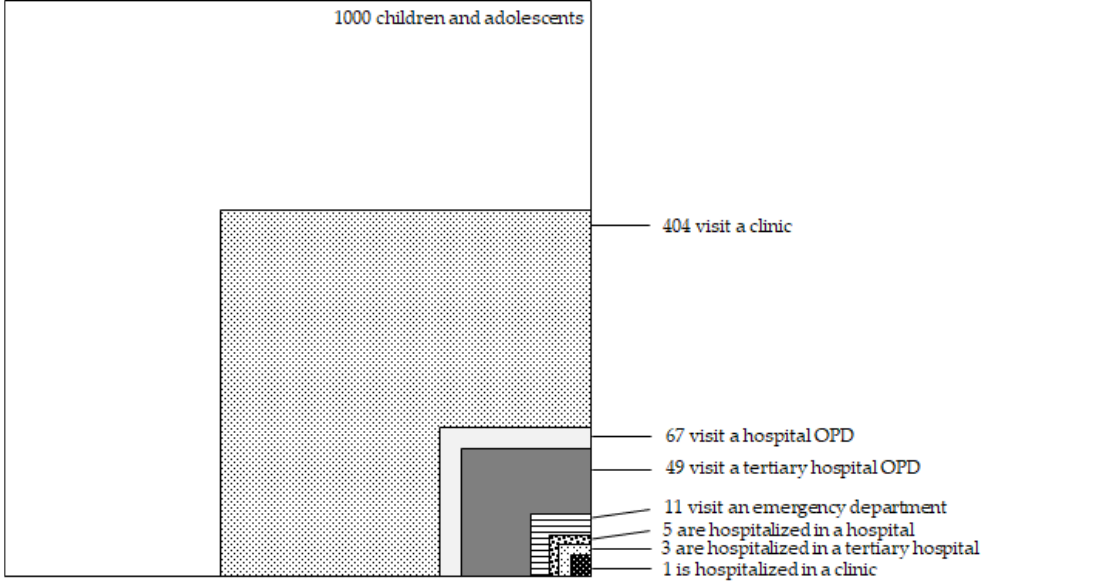
Figure 1. Estimated number of children and adolescents per 1000 people aged 18 years old and younger participating in health care. Abbreviation: OPD — outpatient department. younger participating in health care. Abbreviation: OPD—outpatient